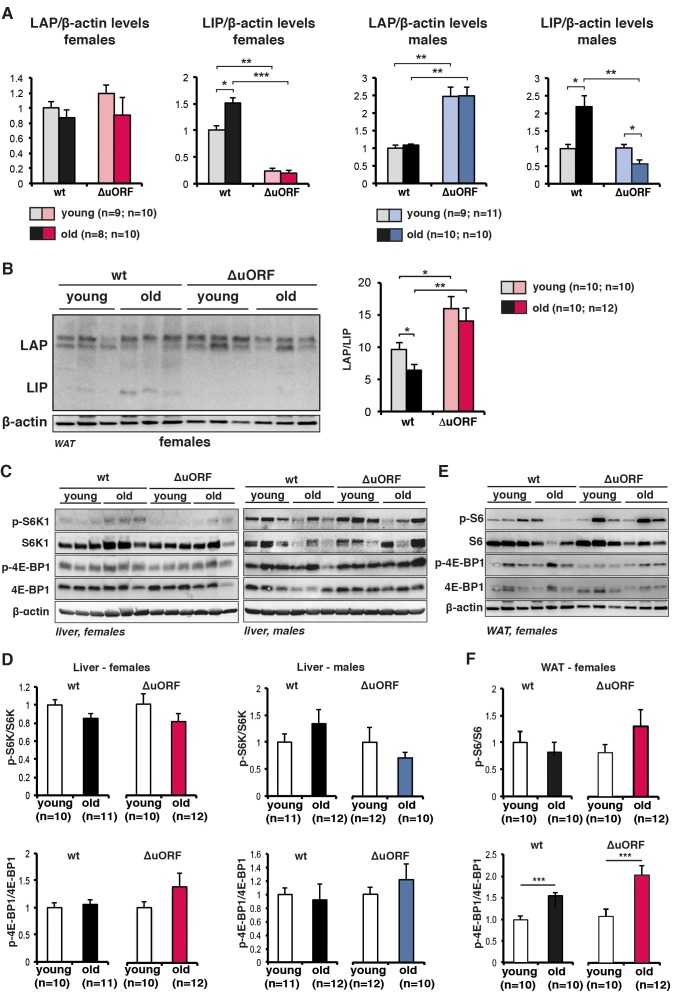
Analysis of C/EBPβ LAP/LIP isoform ratio and mTORC1 signalling upon ageing.(A) Quantification chemiluminescence digital imaging of LAP or LIP signals in livers in respect to β-actin levels using immunoblots presented in Figure 1A and B and additional immunoblots from young (5 month) and old (female 20 months, male 22 months) mice (wt females, n=9 young and old; wt males, n=10 young, n=11 old; C/EBPβΔuORF females, n=10 young, n=11 old; C/EBPβΔuORF males, n=11 young, n=10 old). P-values were determined by Student’s t-test, *p<0.05; **p<0.01; ***p<0.001. (B) Immunoblots of WAT samples from young (5 months) and old (20 months) wt and C/EBPβΔuORF females showing LAP and LIP isoform expression. β-actin expression served as loading control. The LAP/LIP isoform ratio as calculated from quantification by chemiluminescence digital imaging of this and additional immunoblots is shown at the right (wt females, n=10 wt young, n=10 old; C/EBPβΔuORF females, n=10 young, n=12 old). (C) Immunoblots show pan-levels and phosphorylation of the mTORC1 downstream targets S6K1 and 4E-BP1 in liver extracts from young (5 month) and old (females 20 months, males 22 months) of female (left) and male (right) wt and C/EBPβΔuORF mice. The β-actin loading control blots are the same as for Figure 1B and C respectively. (D) Quantification by chemiluminescence digital imaging of phosphorylated proteins in respect to the respective pan levels from the blots presented in (C) and from additional immunoblots (wt females, n=10 young, n=11 old; wt males, n=11 young, n=12 old; C/EBPβΔuORF females, n=10 young, n=12 old; C/EBPβΔuORF males, n=12 young, n=10 old). (E) Immunoblots show pan-levels and phosphorylation of the mTORC1 downstream targets S6 and 4E-BP1 in WAT extracts from young (5 month) and old (20 months) female wt and C/EBPβΔuORF mice. The β-actin loading control blot is the same as in panel B. (F) Quantification by chemiluminescence digital imaging of phosphorylated proteins in respect to the respective pan levels from the blots presented in (E) and from additional immunoblots (wt females, n=10 young, n=10 old; C/EBPβΔuORF females, n=10 young, n=12 old). P-values were determined by Student’s t-test, *p<0.05; **p<0.01; ***p<0.001.